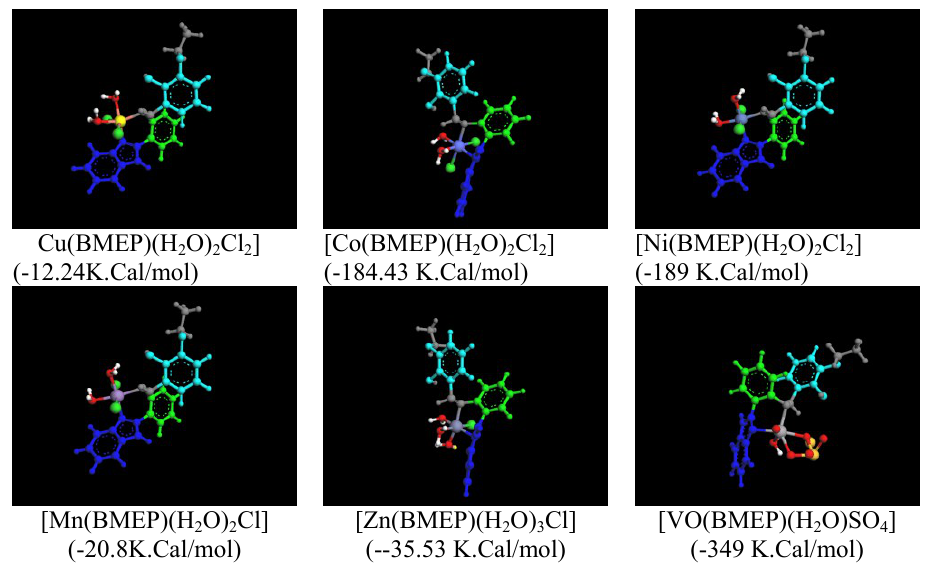
Figure 3. Molecular modeling structures for metal